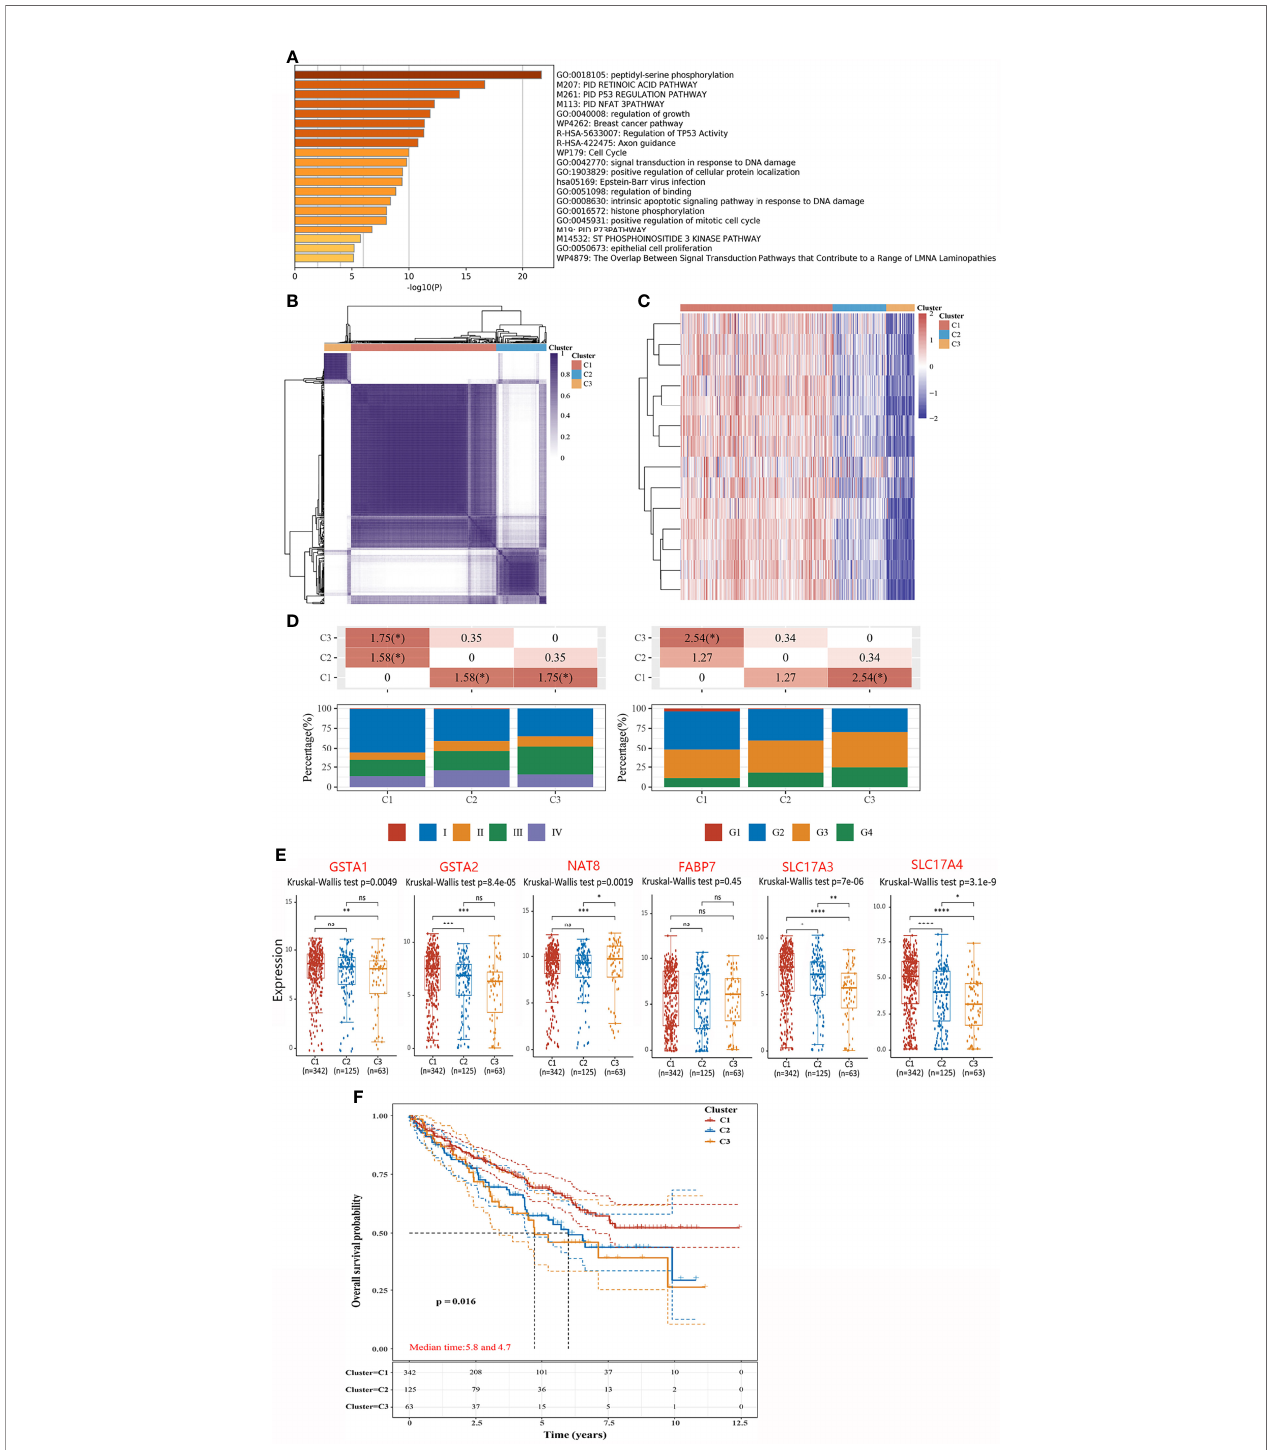
FIGURE 4 | Integrated cluster assignments analysis of ccRCC patients and characteristics described of them. (A) GO Enrichment analyses based on hub genes. (B) Heatmap depicting consensus clustering solution (clusters = 3). (C) Heatmaps showing the expression of hubs in three subgroups. Red represents high expression and blue represents low expression. (D) Distributions of tumor stage (left) and the degree of progression of the primary tumor (right) in three subgroups. The table above represents the distribution of a certain clinical feature in any two subgroups. The signi fi cance p-value was analyzed by chi-square test, where the value is − log10 (p value), if marked with *, it means that there is a signi fi cant difference in the distribution of the clinical feature in the corresponding two groups (p <0.05). (E) The expressions of DEGs in three subgroups. (F) Kaplan – Meier curves describe the OS for three subgroups. *P < 0.05, **P < 0.01,***P < 0.001, ns, no signi fi